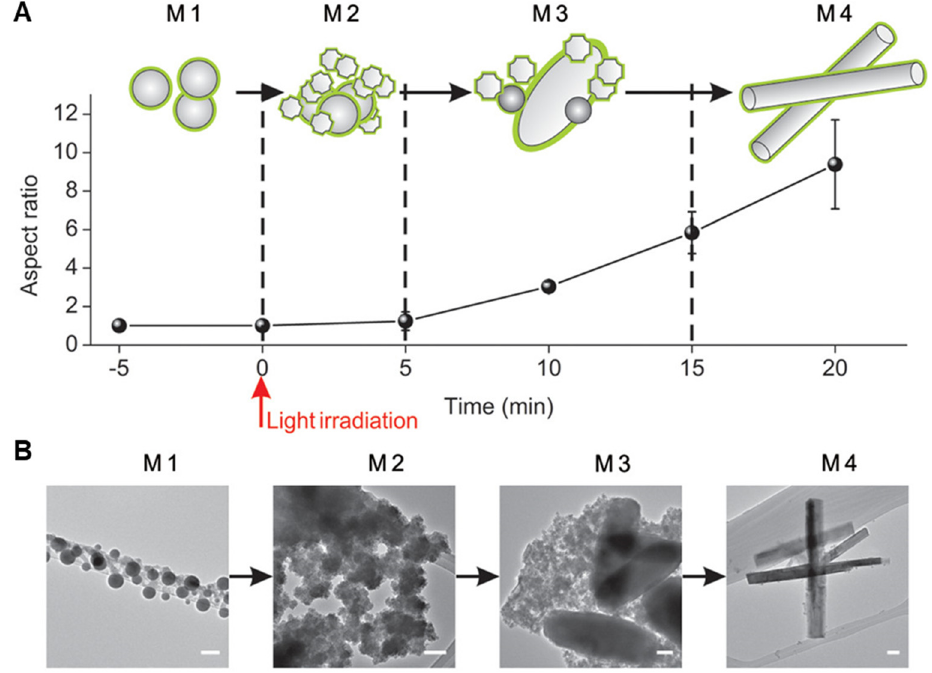
Figure 5. Shape transformation of graphene quantum dot (GQD)-coated LMNPs. ( A ) Schematic changes the four stages (M1, M2, M3, and M4) of LMNPs over light irradiation time. ( B ) Representative TEM images of the four transformation stages. Scale bars: 100 nm. Reproduced with permission from ACS [14].